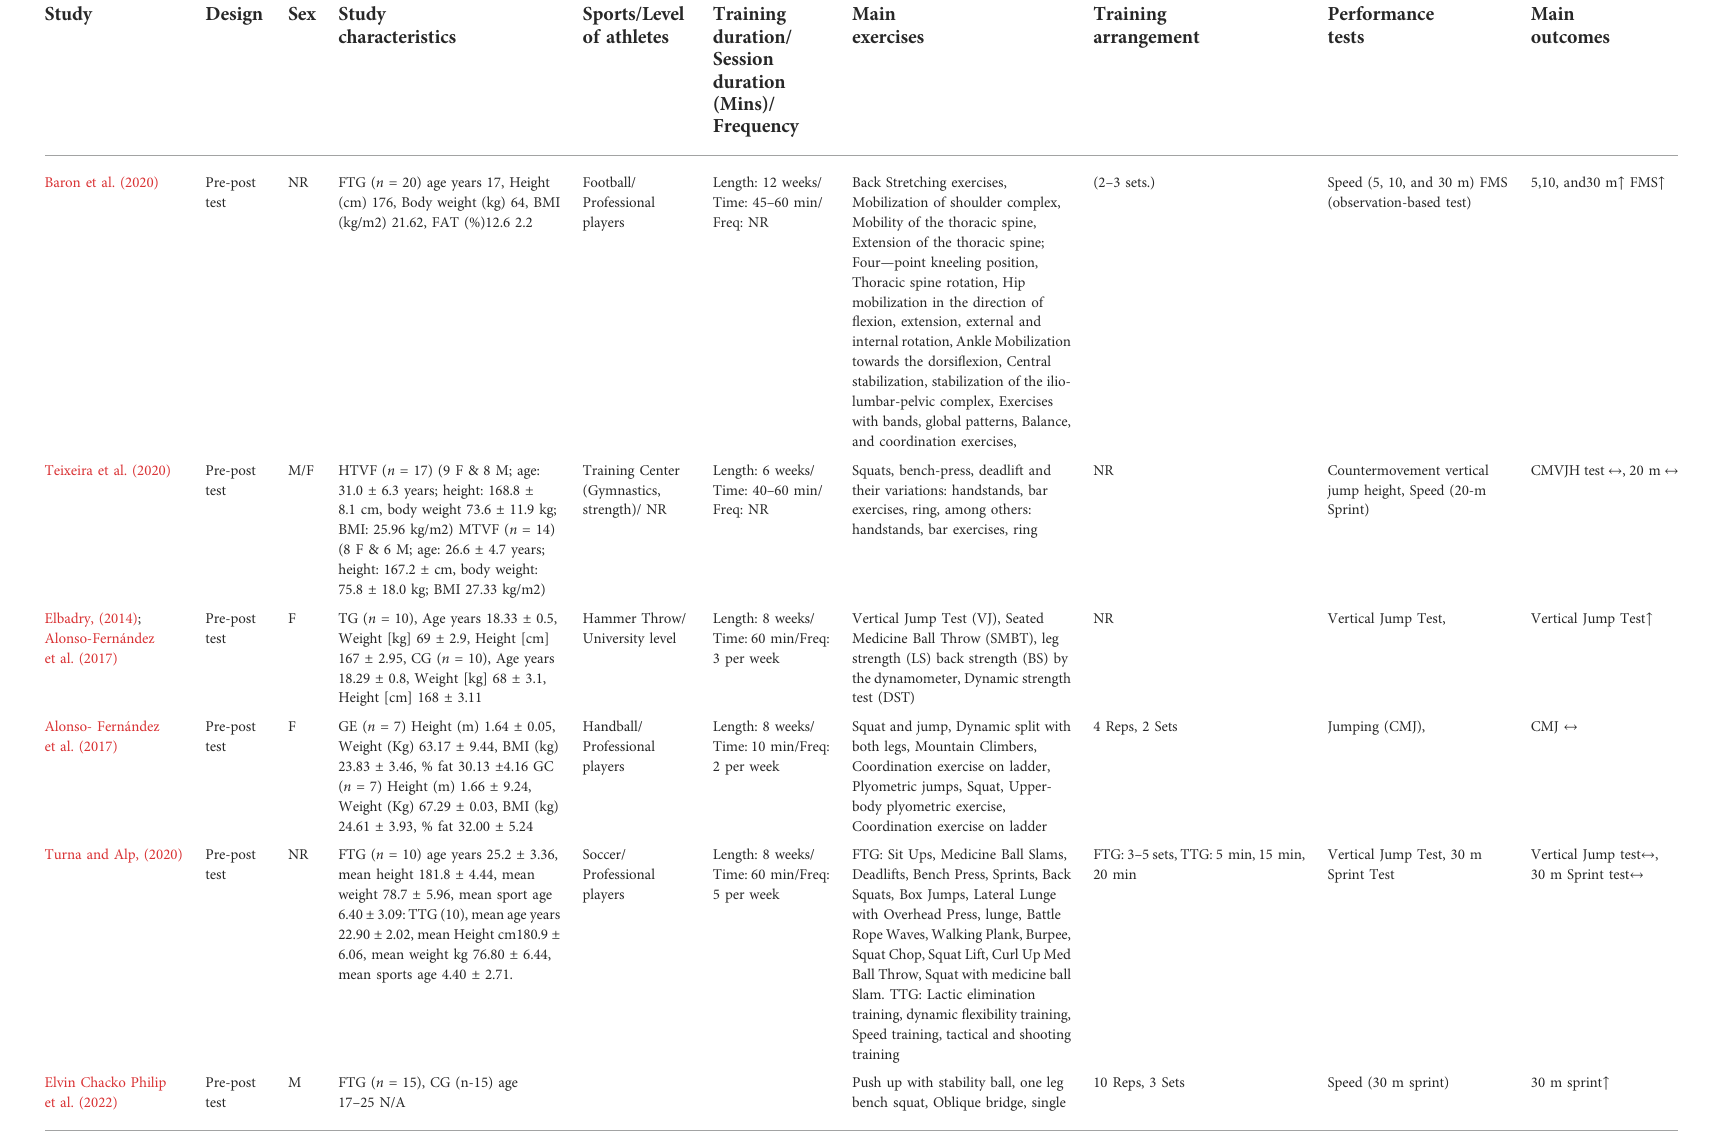
FTG: Sit Ups, Medicine Ball Slams, Deadlifts, Bench Press, Sprints, Back Squats, Box Jumps, Lateral Lunge with Overhead Press, lunge, Battle RopeWaves,WalkingPlank,Burpee, SquatChop,SquatLift,CurlUpMed BallThrow,Squatwithmedicineball Slam. TTG: Lactic elimination training, dynamic fl exibilitytraining, Speed training, tactical and shooting training